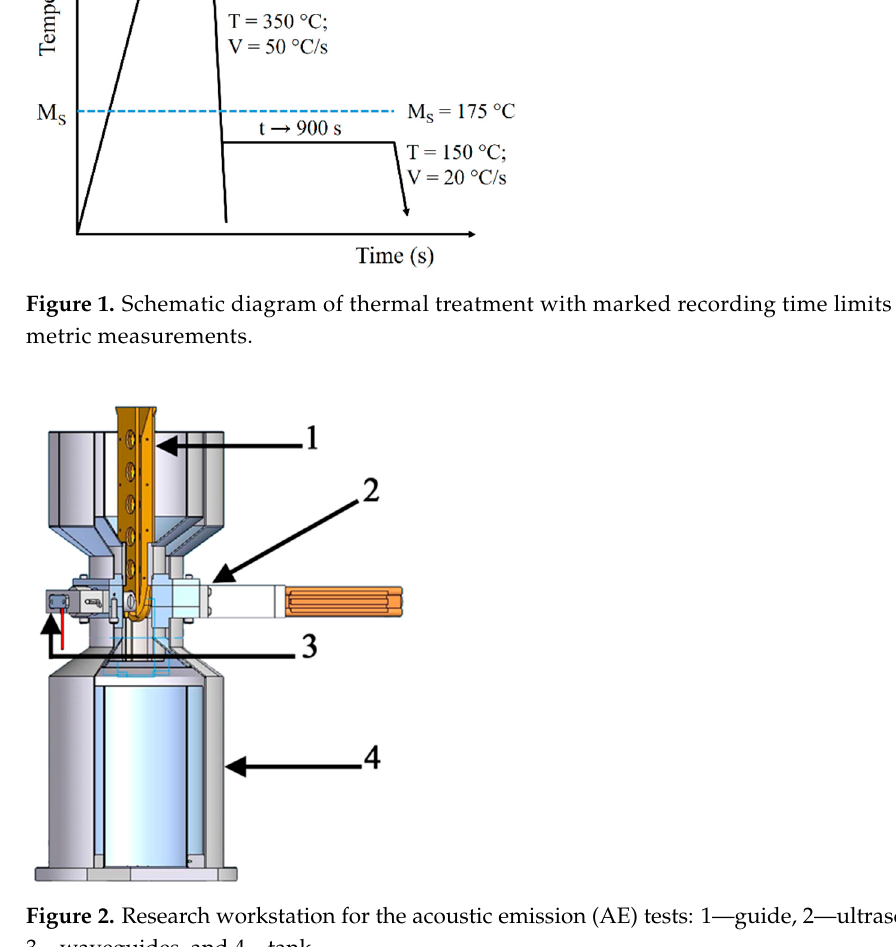
Figure 2. Research workstation for the acoustic emission (AE) tests: 1—guide, 2—ultrasonic sen- sor, 3—waveguides, and 4—tank.